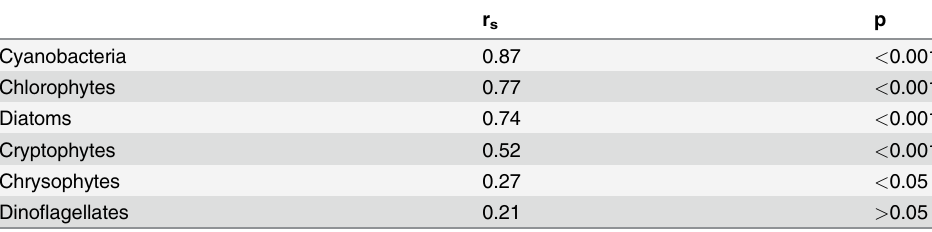
Table 3. Spearman rank order correlation coefficients of phytoplankton classes assessment by mi- croscopy and CHEMTAX in Lake V õ rtsjärv in 2009 –